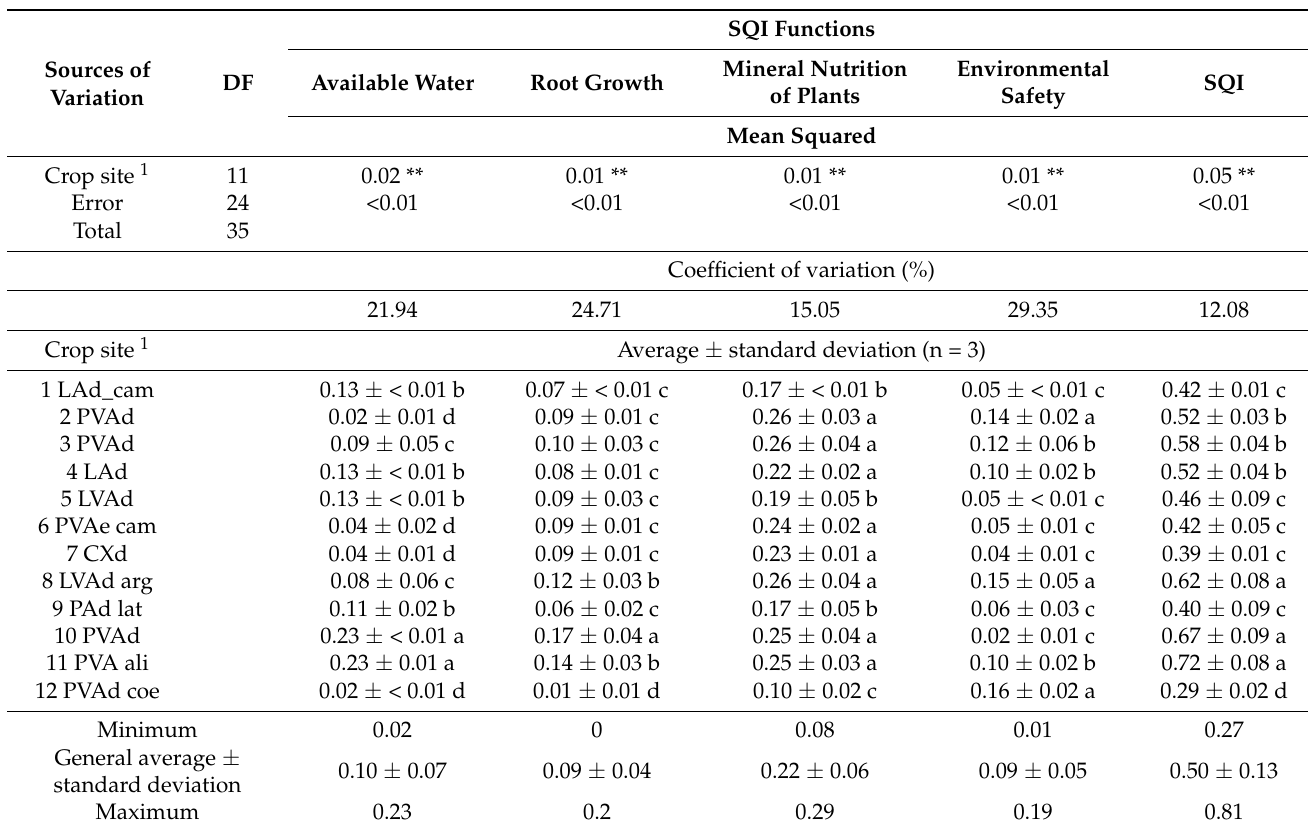
Table 1. Edaphic crop conditions of the PH-16 cacao clon in the humid zone of southeast Bahia, Brazil represented by the Soil Quality Index (SQI) and its